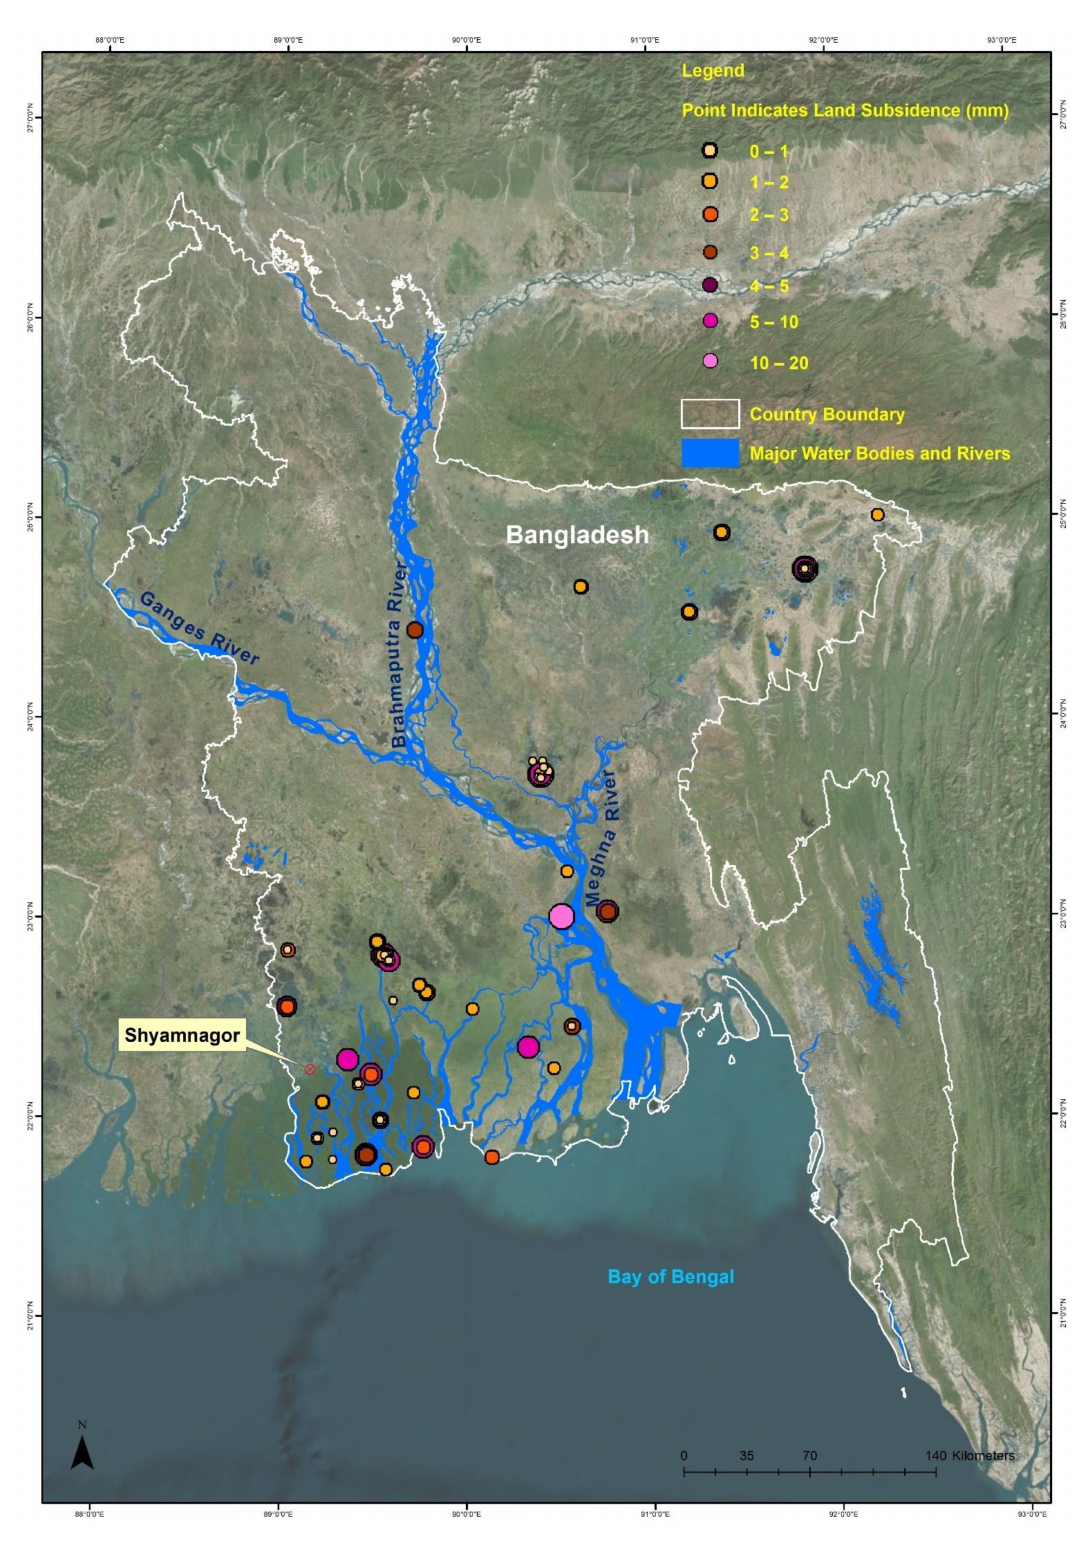
Figure 8. Focal areas of subsidence in the GBM Delta (Source: Rates of subsidence retrieved from Brown and Nicholls, 2015)